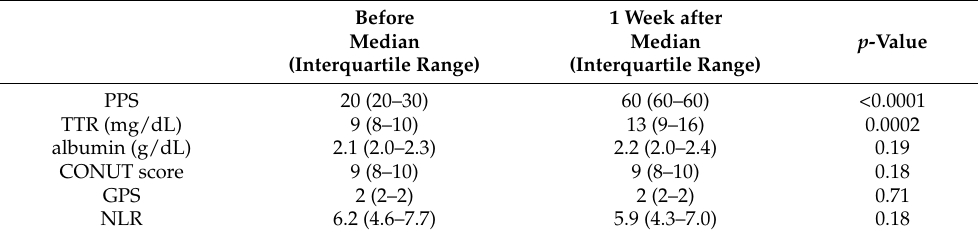
Table 2. Changes of indices by symptom management and